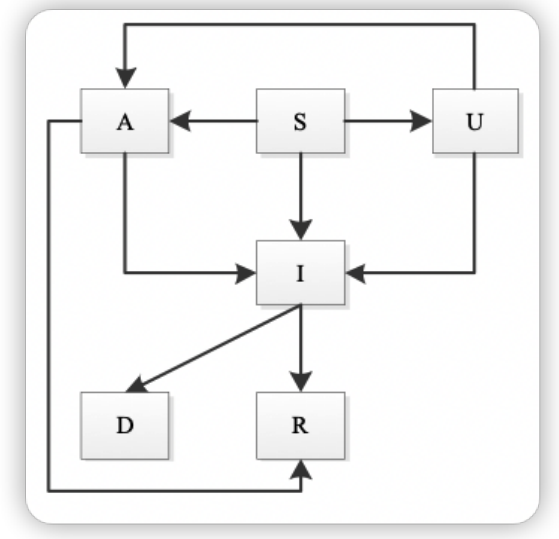
Figure 1. Flow chart of the relationship between each